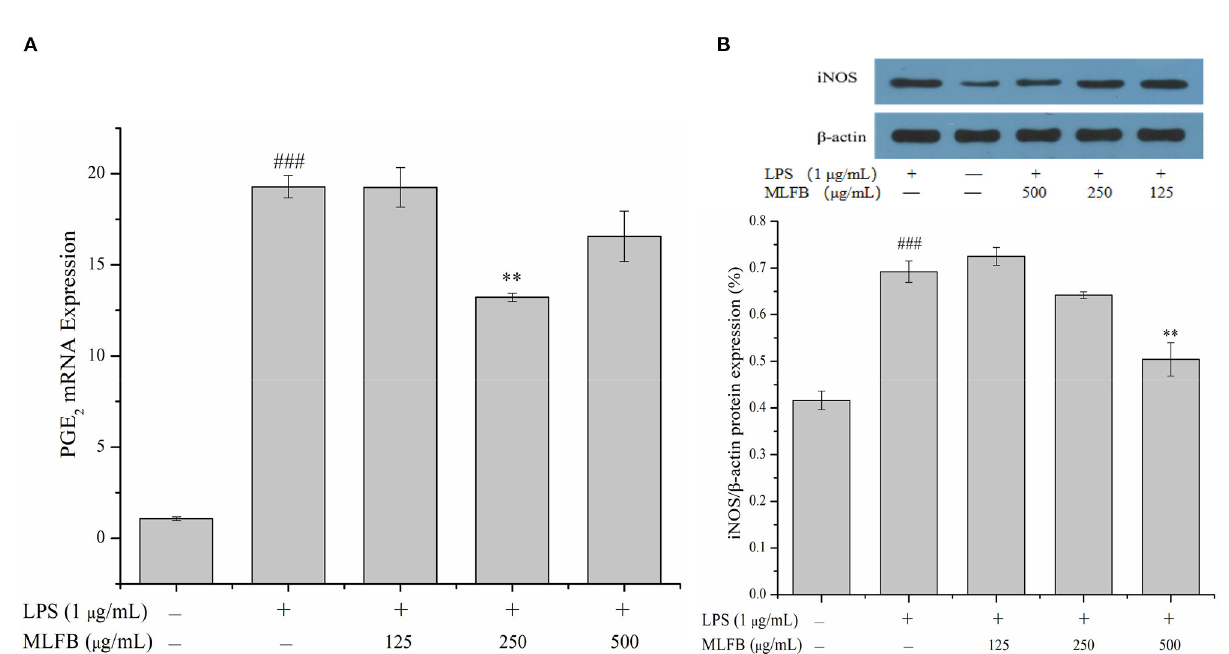
FIGURE5 Effects of MLFB on the expressions of PGE 2 (A) and iNOS (B) in LPS-induced RAW 264.7 cells. # Means statistical difference compared with blank control group ( ### P < 0.001). *Means statistical difference compared with LPS-induced inflammatory model group (** P <